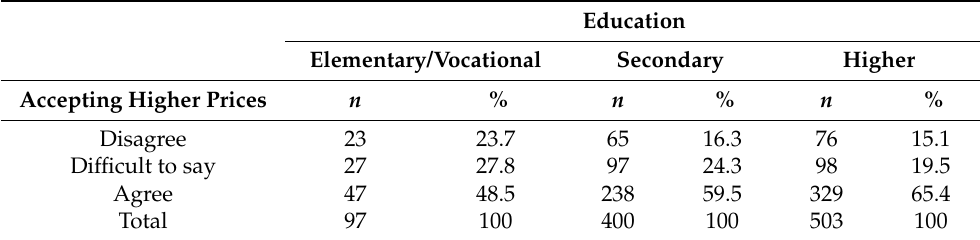
Table 2. Acceptance of higher prices for products that do not cause damage to the environment depending on respondents’ level of education.